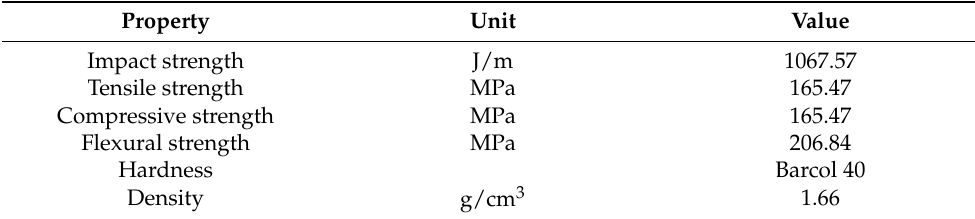
Table 1. Physical and mechanical properties of the